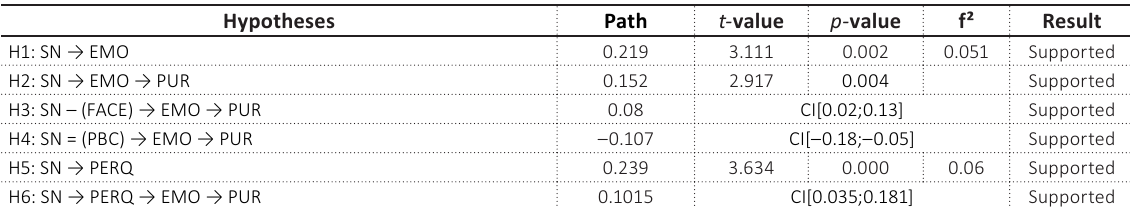
Table 8. Hypothesis